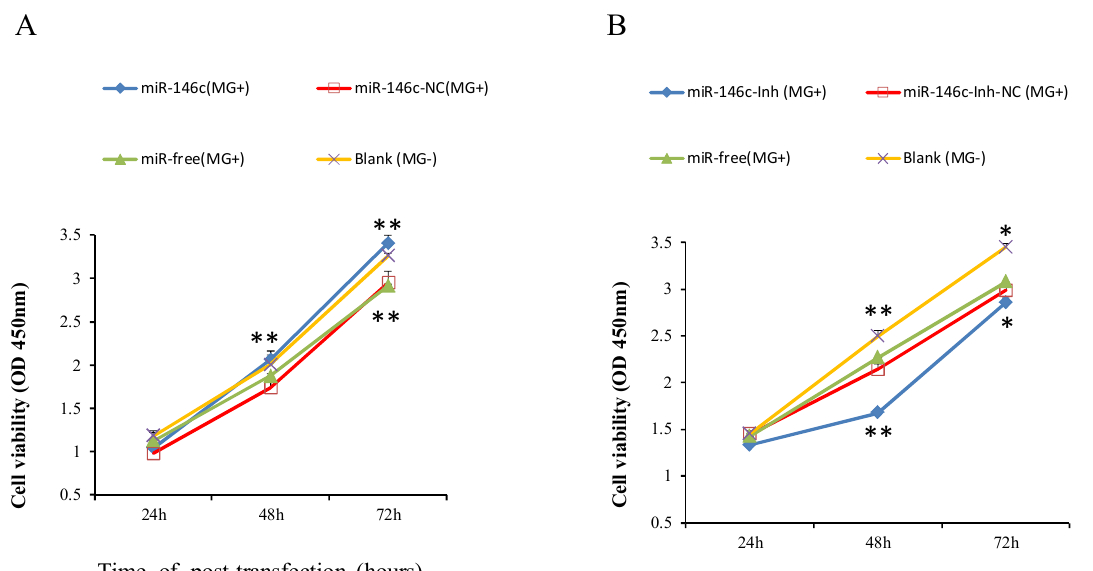
Figure 6. Proliferation of DF-1 cells was regulated by gga-miR-146c. Four groups of transfection treatments were carried out. Values are mean ± SD, * p < 0.05, ** p < 0.01. ( A ) Cell multiplication was dramatically promoted with gga-miR-146c overexpressed; ( B ) Cell multiplication was restrained by gga-miR-146c inhibitor.